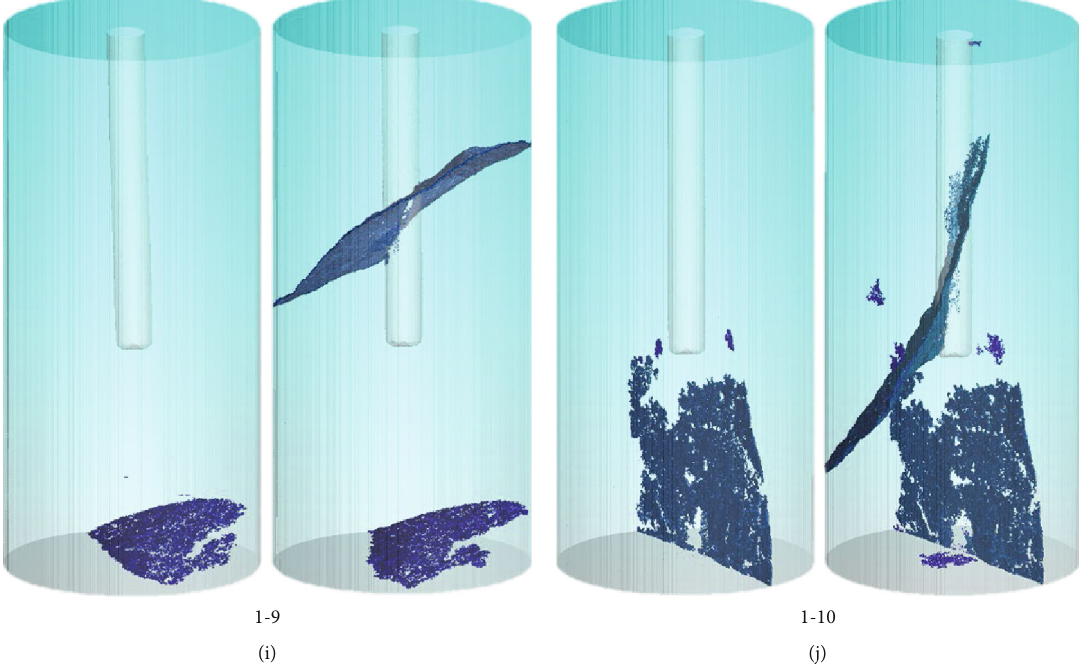
Figure 8: 3-D fracture networks of sandstone samples before and after hydraulic fracturing. (a) 1-1. (b) 1-2. (c) 1-3. (d) 1-4. (e) 1-5. (f) 1-6. (g) 1-7. (h) 1-8. (i) 1-9. (j)